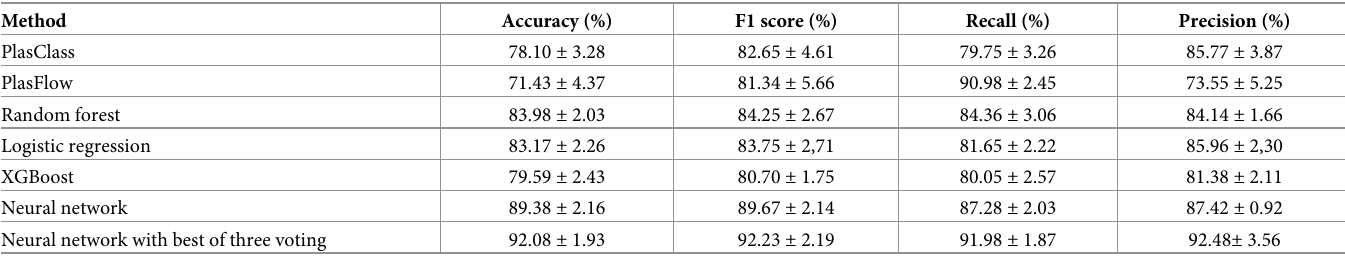
Table 4. Comparison of the performance of PlasFlow and PlasClass with the models built in this study for the same test dataset in the 10-fold cross validation �